Question: What does this figure show? Answer in one sentence.
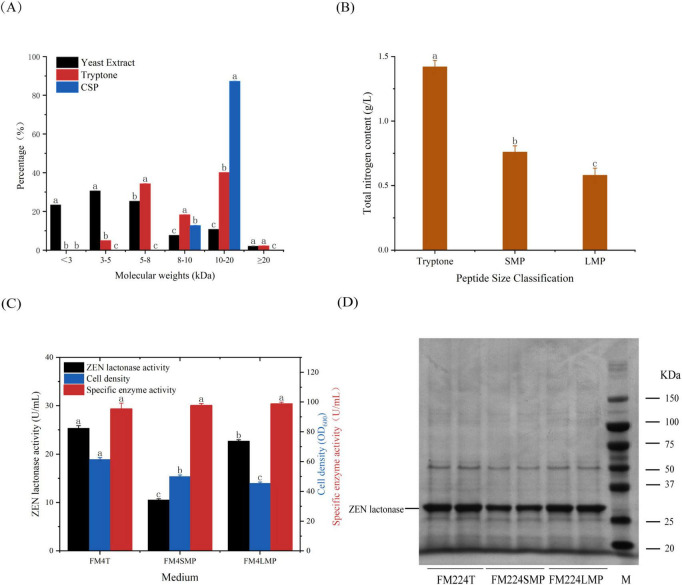
Answer: Peptide composition of organic nitrogen sources and their effects on ZEN lactonase production. (A) Peptide molecular weight distribution of the three organic nitrogen sources. (B) Total nitrogen content of tryptone and its fractionated components (SMP and LMP). (C) Effects of tryptone and its fractions on ZEN lactonase production and cell density. (D) SDS–PAGE analysis of ZEN lactonase production. Large peptides are beneficial for ZEN lactonase production, as demonstrated by the LMP fraction. Different letters indicate statistically significant differences between groups ( p < 0.05).